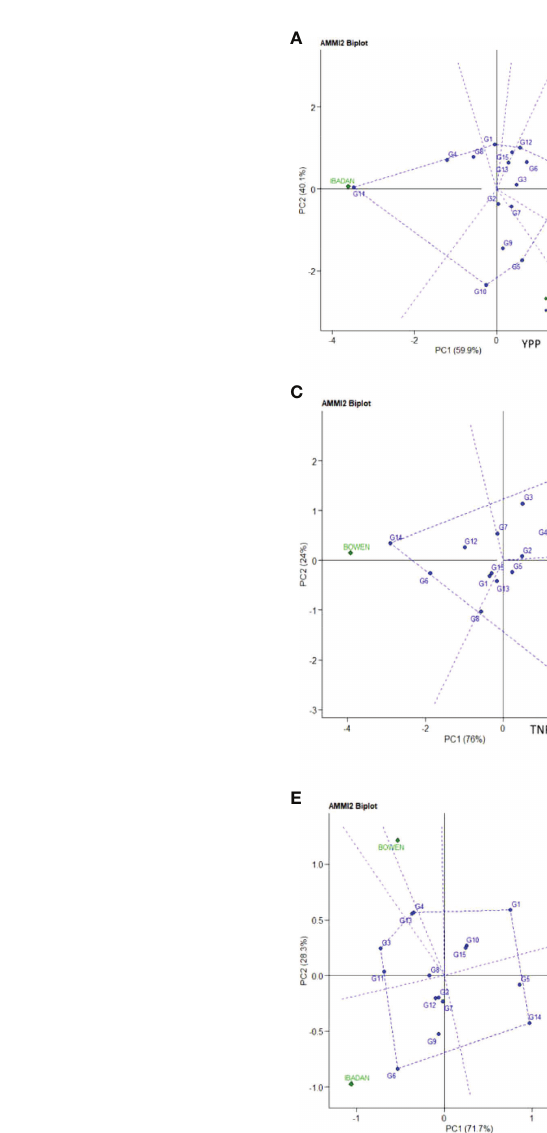
F). The only genotype that fell inside the inner circle was G8; the genotypes next to the ideal inner circle were G3 and G10, followed by G13, G6, G4, and G11 for YPP (Figure 4: Pattern A). Similarly, for FPW, the only genotype was G8, while G13, G3, G11, G10, and G4 were next to the ideal genotype (Figure 5: Pattern B). For TNPP, the only genotype was G8, while G6, G3, G13, and G14 followed the only ideal genotype (Figure 4: Pattern C). For HSW, there were no genotypes inside the inner circle, but the genotypes next to the inner cycle were G8, G4, G13, G11, G10, G3, G2, and G6 (Figure 4: Pattern D). For LOS, there were no genotypes inside the inner circle, but genotypes G11, G13, G4, G8, G10, G9, and G6 were next to the inner cycle (Figure 4: Pattern E). For WOS, the only genotype that was placed inside the inner cycle was G4, while G8, G11, G13, G9, G10, and G2 were next to the ideal genotype (Figure 4: Pattern F).